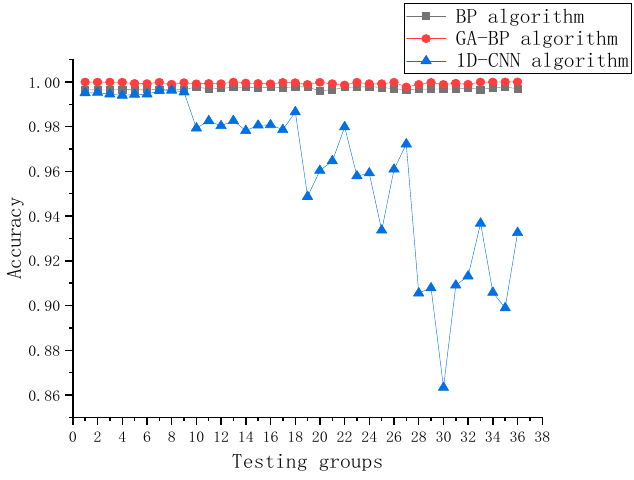
Figure 8. Accuracy of the three algorithms.